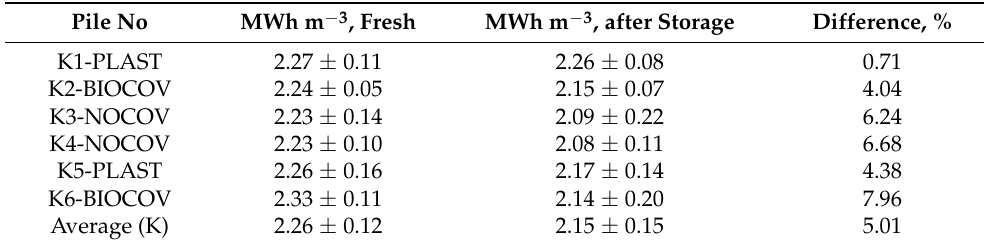
Table 3. Energy content (MWh m − 3 ) of the piles with different cover alternatives in the Kuopio (K) experiment in average values and standard